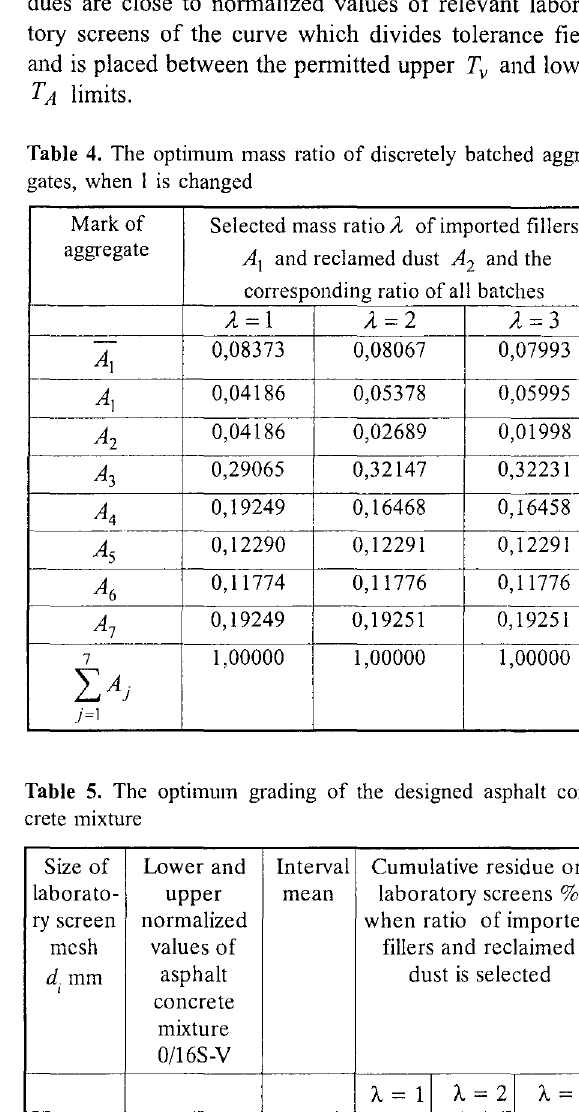
Table 4. The optimum mass ratio of discretely hatched aggre gates, when I is changed